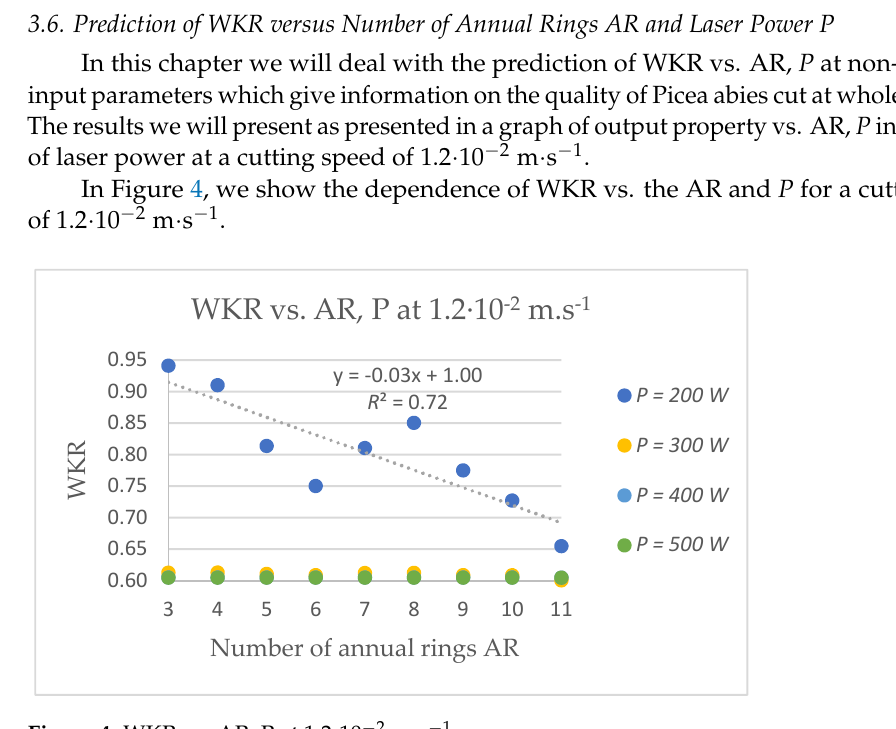
Figure 4. WKR vs. AR, P at 1.2·10 − 2 m.s − 1.